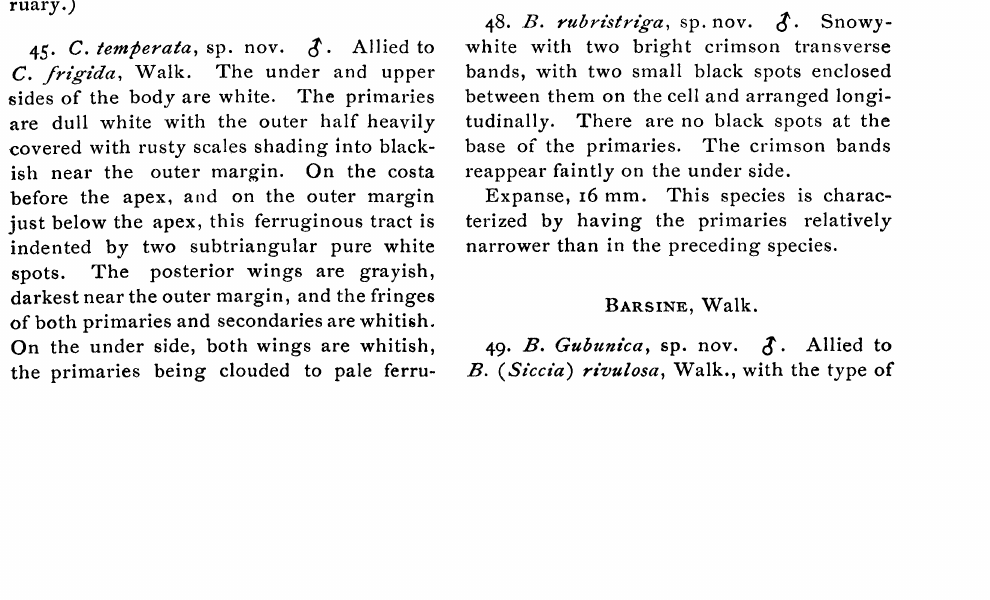
front, collar, and thorax white. Legs pale yellow. Abdomen gray. Upper side of an- terior wings milk-white with two small oval pale fawn spots arranged longitudinally in the cell beyond the middle, a small spot of the same color at the base, a moderately large brown blotch below the cell near the middle tapering inwardly toward the base, and a limbal band broadest near the posterior mar- gin. The apex broadly fawn color with a series of small spots of the same color on the outer margin between the nervules, gradually diminishing in size toward the outer angle. The posterior wings are very pale semi-trans- lucent fawn color. The under side of both wings is of the same color as the upper side of the secondaries. The costa and the outer and inner margins of the primaries are paler.